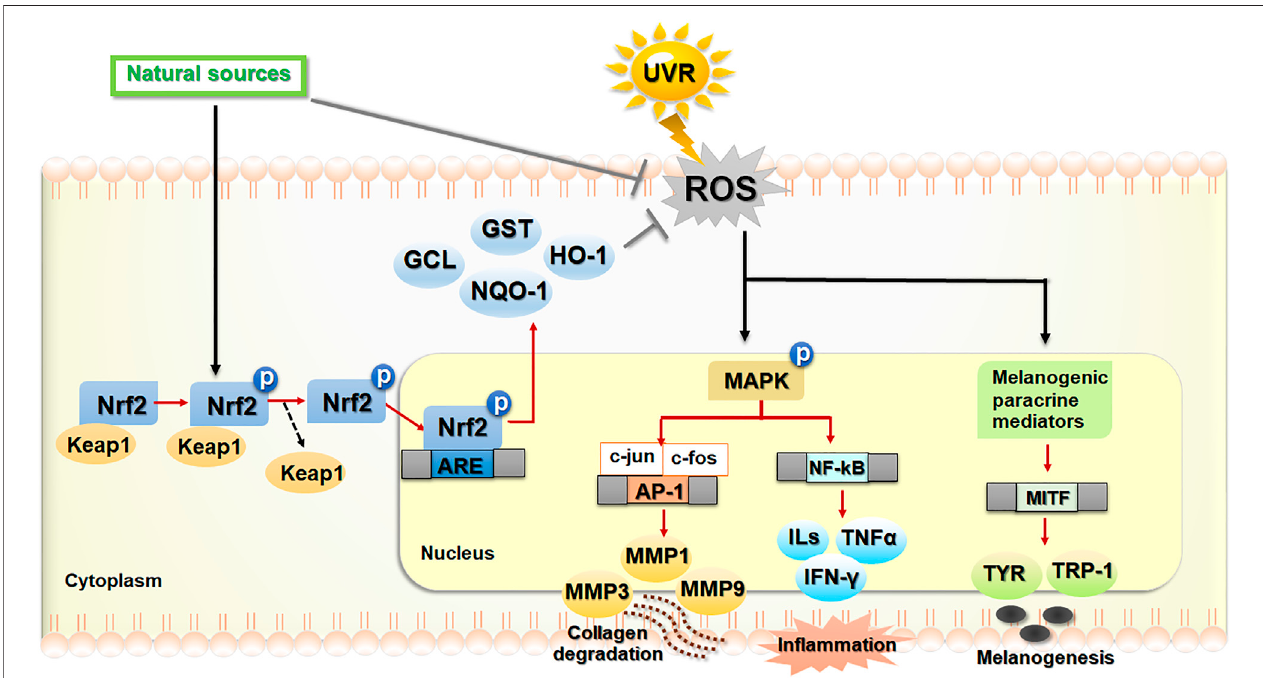
FIGURE 3 | The regulatory mechanism of Nrf2-dependent antioxidant and cytoprotective actions against photoaging, in fl ammation and hyperpigmentation. Phytochemicalsplayaphotoprotectiveroleagainstskinphotodamagedirectly via scavengingreactiveoxygenspecies(ROS)andindirectlyviaactivationofnuclearfactor erythroid2-related factor 2(Nrf2)signaling,leadingtoupregulationofantioxidant and cytoprotectivegenes.Inresponse toultravioletray (UVR)-induced oxidativestress, ROS, produced in keratinocytes, melanocytes and fi broblasts, can modulate several related signaling pathways involved in photoaging, in fl ammation and melanogenesis. Exposure of human skin to UVR causes cells to produce ROS, which can modulate the signaling pathways involved in upregulation of matrix metalloproteinases(MMPs)whichincludesMMP-1/3/9,leadingtocollagendegradation,in fl ammation(nuclearfactorkappaBalsoknownasNF- κ Banditsdownstream signaling) and the upregulation of melanogenesis-related genes including the microphthalmia-associated transcription factor (MITF), tyrosinase (TYR), and tyrosinase relatedproteins(TRP-1).DietaryphytochemicalsasnaturalsourcesofantioxidantsplaytheprotectiverolesagainstUVR-inducedROSbytheinhibitionofROSformation and the activation of Nrf2 signaling. In response to oxidative insults, Nrf2 is activated by the phosphorylation and disassociation of Nrf2 from Kelch-ECH associated protein 1 (Keap1), a repressor protein in the cytoplasm. Then, Nrf2 translocated to the nucleus binds to the ARE in the promoter region of downstream genes encoding antioxidant and phase II detoxifying enzymes including glutamate cysteine ligase (GCL), glutathione S-transferase (GST), NAD(P)H quinone oxidoreductase-1 (NQO-1), heme oxygenase-1 (HO-1). The activation of Nrf2 improves oxidative status of the cells and promotes cytoprotection against skin oxidative damage and in fl ammation. The black/red arrows and bar-headedlines mean activation andinhibitionofthe pathway, respectively. Thedash arrow meansdissociation oftheKeap1 –